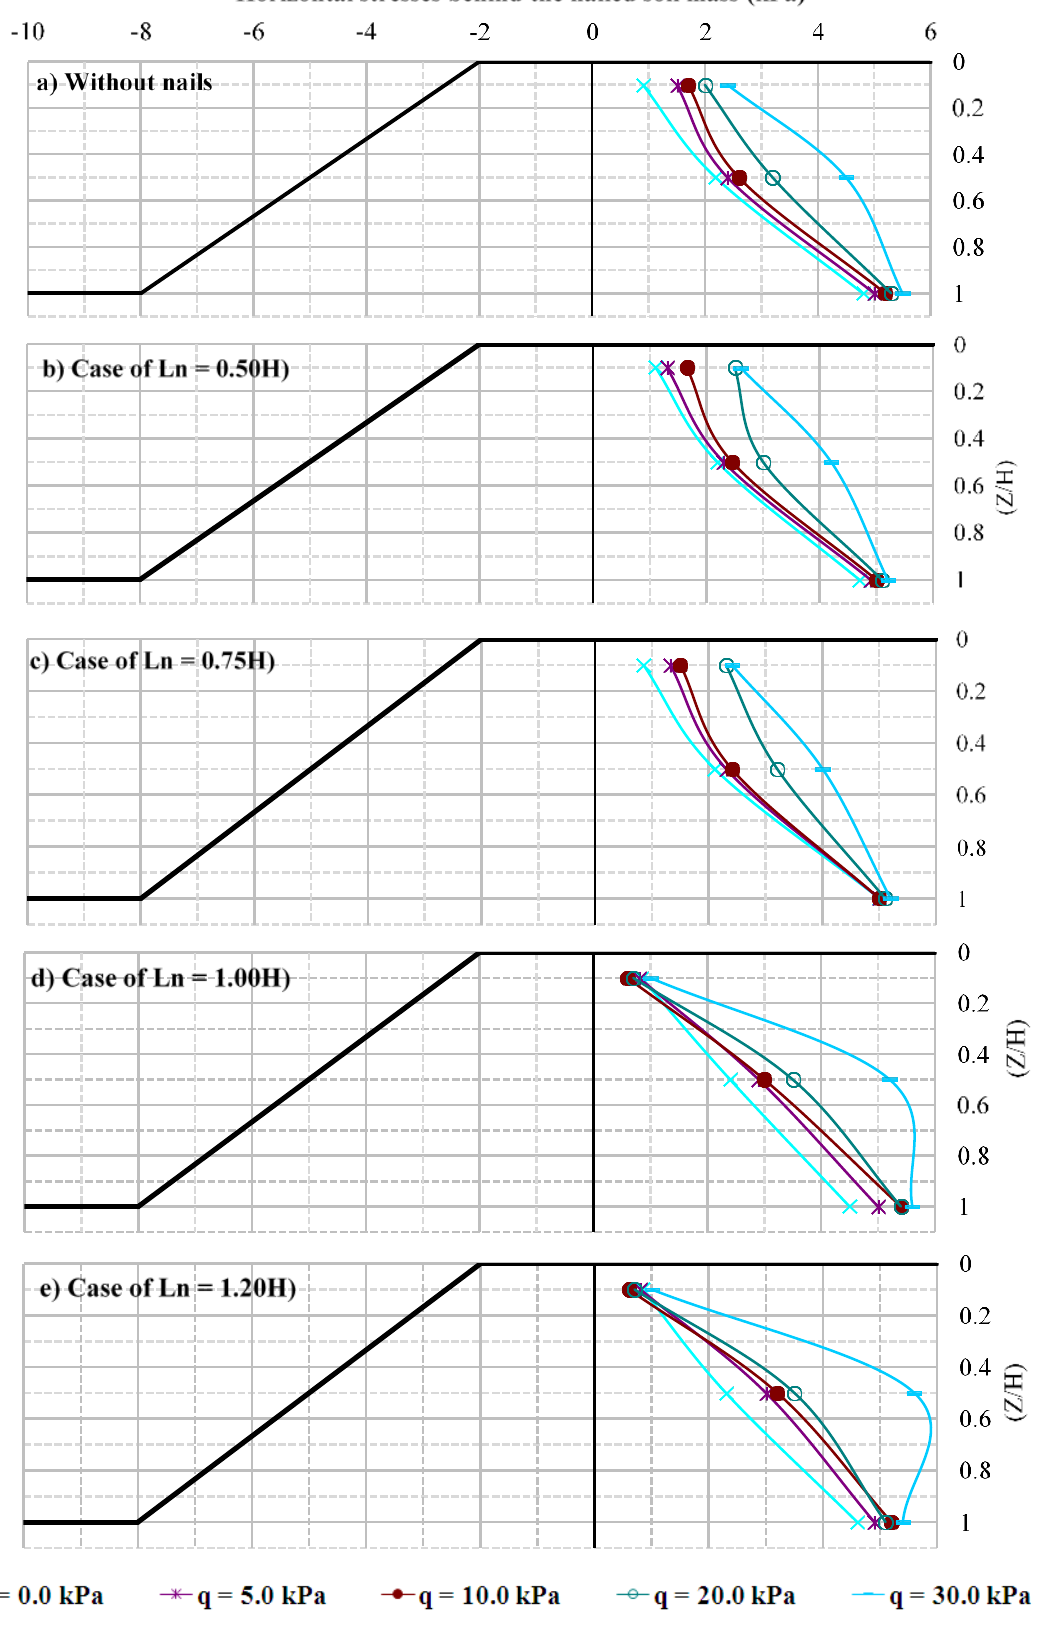
Figure 13. Distribution of horizontal stresses behind the soil mass at different nail lengths.